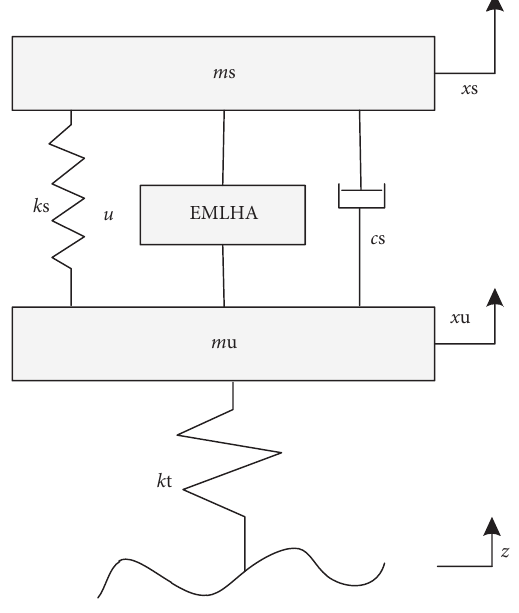
Figure 3: Dynamic model with 2-DOF of